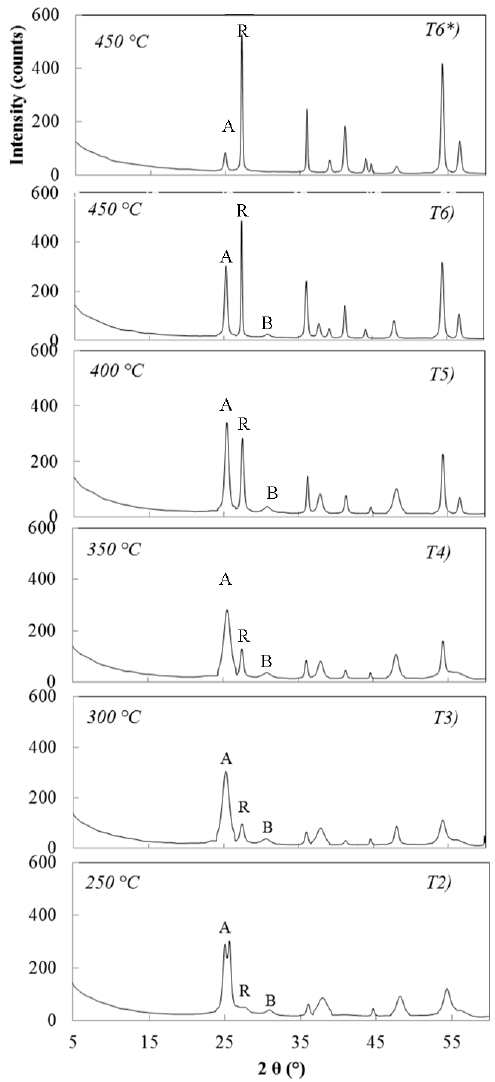
Figure 6. XRD patterns of samples T2, T3, T4, T5, T6, T6* reported in Table 2. (A = anatase; R = rutile; B = brookite).